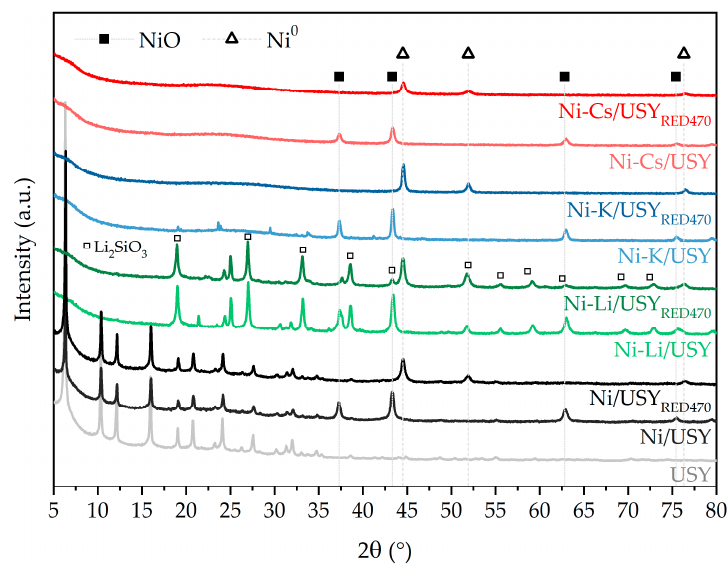
Figure 1. XRD patterns obtained for Ni-A/USY catalysts after calcination and reduction.